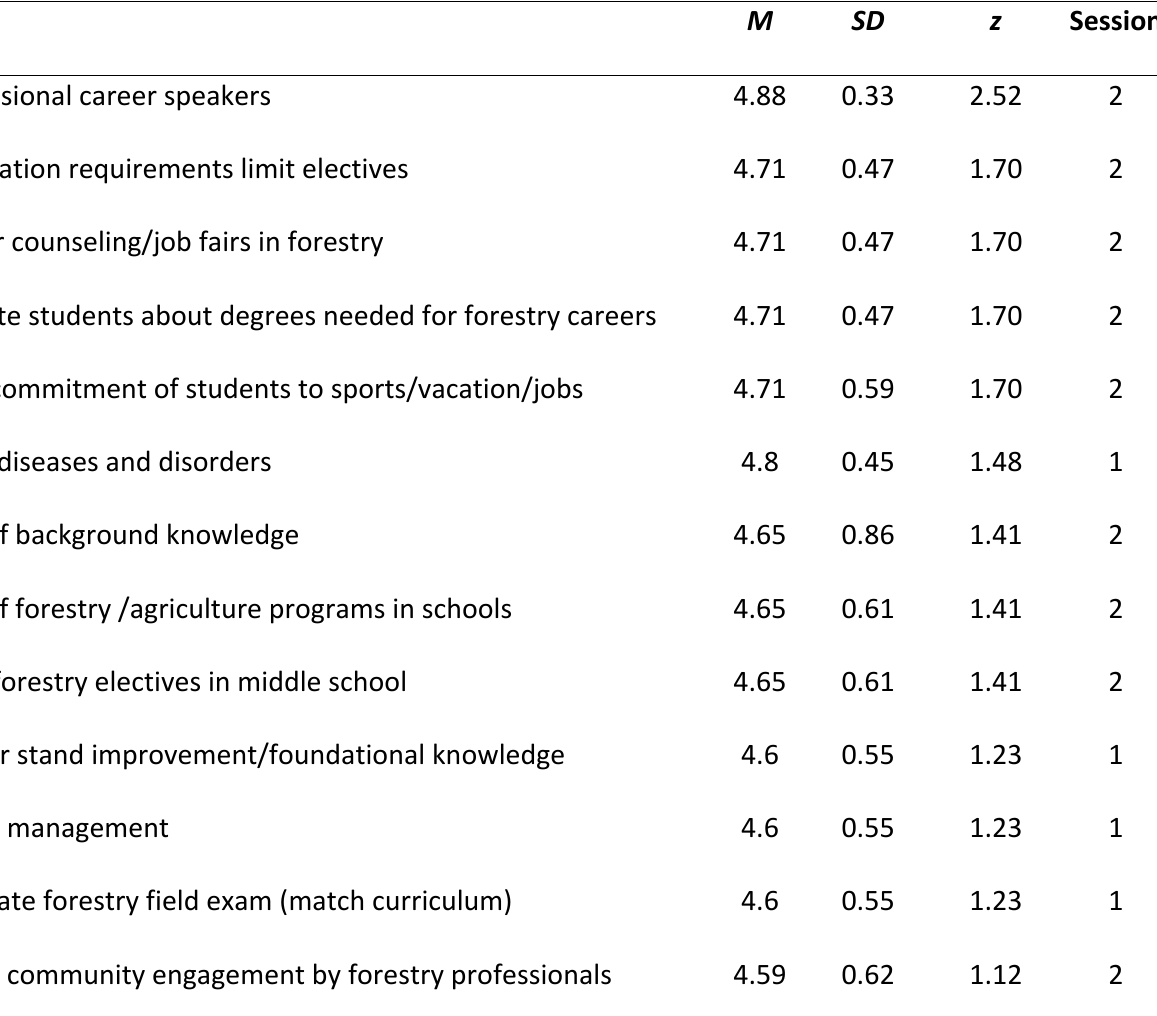
Professional Development Needs Ranked by Z-score Combined from Session 1 and